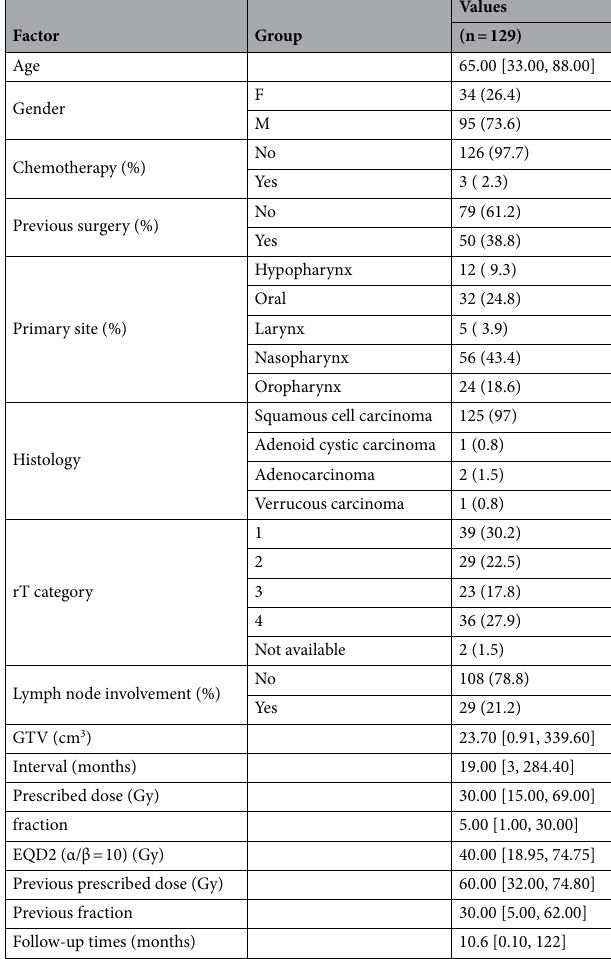
Multivariate analysis revealed that the primary site (nasopharynx; hazard ratio = 2.96, p = 0.0024) and small GTV volume ≤ 25 cm3 (hazard ratio = 2.03, p = 0.013) were statistically significant favorable predictive factors for OS (Table 2). Age, gender, lymph node involvement, the interval between initial radiotherapy and reirradiation, previous surgery, chemotherapy, and prescribed dose in EQD2 were not statistically significant predisposing factors for overall survival. Patients with nasopharyngeal cancer showed a higher 2-years survival rate of 59.6% (95% CI 43.7–72.4%), than other primary sites of 23.5% (95% CI 12.8–36.0%, p = 0.0002, Fig. 1c). Patients with small GTV ≤ 25 cm3 showed a higher 48.1% (95% CI 33.5–61.4%) 2 ― year overall survival rate than those with large GTV > 25 cm 3 of 30.8% (95% CI 17.2–45.5%, p = 0.00311, Fig. 1d). Patients with rT1 disease showed superior 2 ― year survival rates of 57.6% (95% CI 38.8–72.6%), compared with patients with rt2, rT3, and rT4 diseases with 2 ― year survival rates of 40.3% (21.6–58.2%), 32.1% (11.3–55.2%) and 23.2% (8.06–42.9%), respectively (Supplementary Fig. 1, p = 0.00627). Local failure was observed in 43 patients (33%) with an initial tumor progression. The local control rate was 63.8% (95% CI 53.2–72.6%) at 1-year and 58.2% (95% CI 46.7–68.1%) at 2 years (Fig. 2). For each primary site, the 2-year local control rate was 64.8% (95% CI 31.0–85.2%), 43.4% (95% CI 20.5–64.5%), 80% (20.4–96.9%), 68.0% (95% CI 51.0–80.0%), and 44.4% (95% CI 18.2–67.8%) for the hypopharynx, oral, laryngeal, nasopharynx, and oropharynx, respectively (p = 0.182) (Fig. 2b). In addition, there is a statistical difference between the naso- pharynx and others. The 2-year local control rate was 68.0% (95% CI 51.0–80.0%) for nasopharyngeal cancer and 50% (95% CI 34.6–63.6%) for other primaries (Fig. 2c, p = 0.0293). Nine patients showed distant metastases (3 skin, 3 liver, 2 supraclavicular lymph nodes, 3 lungs and/or medi- astinal lymph node, 1 axillary lymph node, 1 peritonitis carcinomatosa, and 1 pleural effusion; three patients showed multiple metastases).